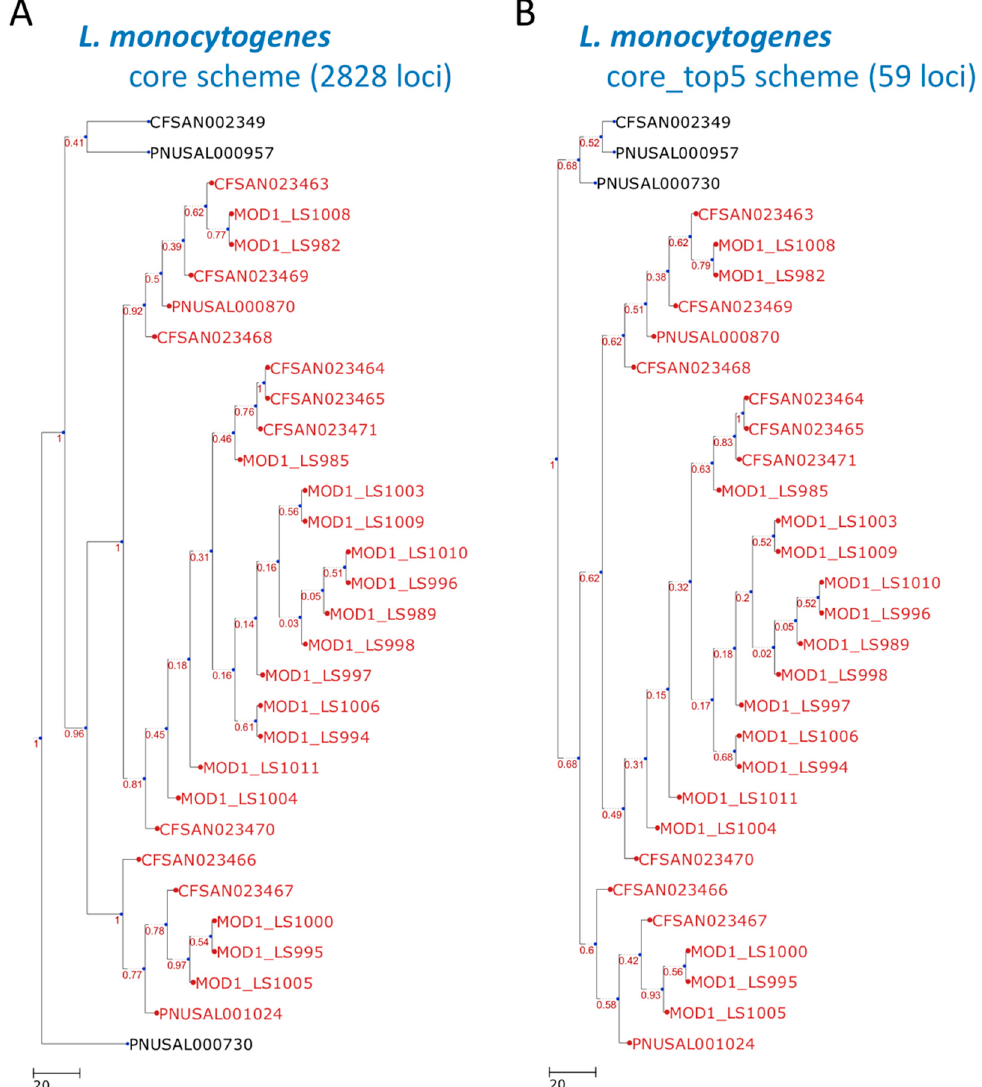
Figure 2. Dendrogram constructed with cgMLST profiles for 31 Listeria monocytogenes isolates. The cgMLST trees were generated according to the ( A ) core scheme (2828 loci) and ( B ) core_top5 scheme (59 loci). The outbreak or event-related taxa are colored red. The core scheme refers to the core genome scheme generated in step 2 by the PGAdb Builder. The core_top5 scheme is a subset of the core scheme that unites the five most discriminatory loci for each split. The scheme was generated in step five by the Loci Extractor.